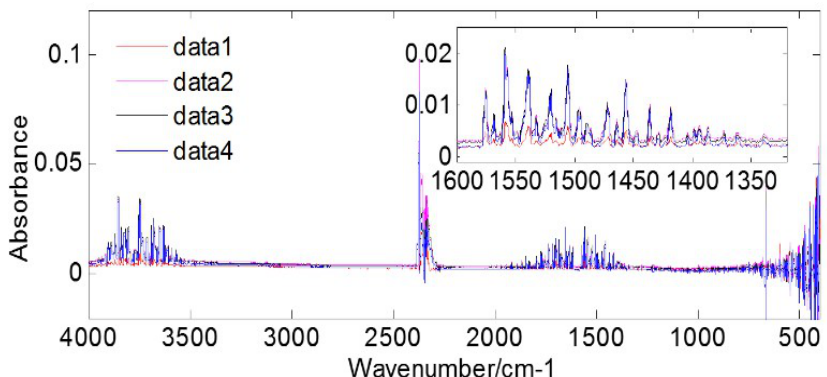
Figure 7. Spectra scanned continuously just after the analyzer was put into use. “data i ” means the i th spectrum. The absorption peak height of water vapor of “data4” is almost the same of that “data3”, which means that only three times the amount of degassing can put the degassing process into stable state.